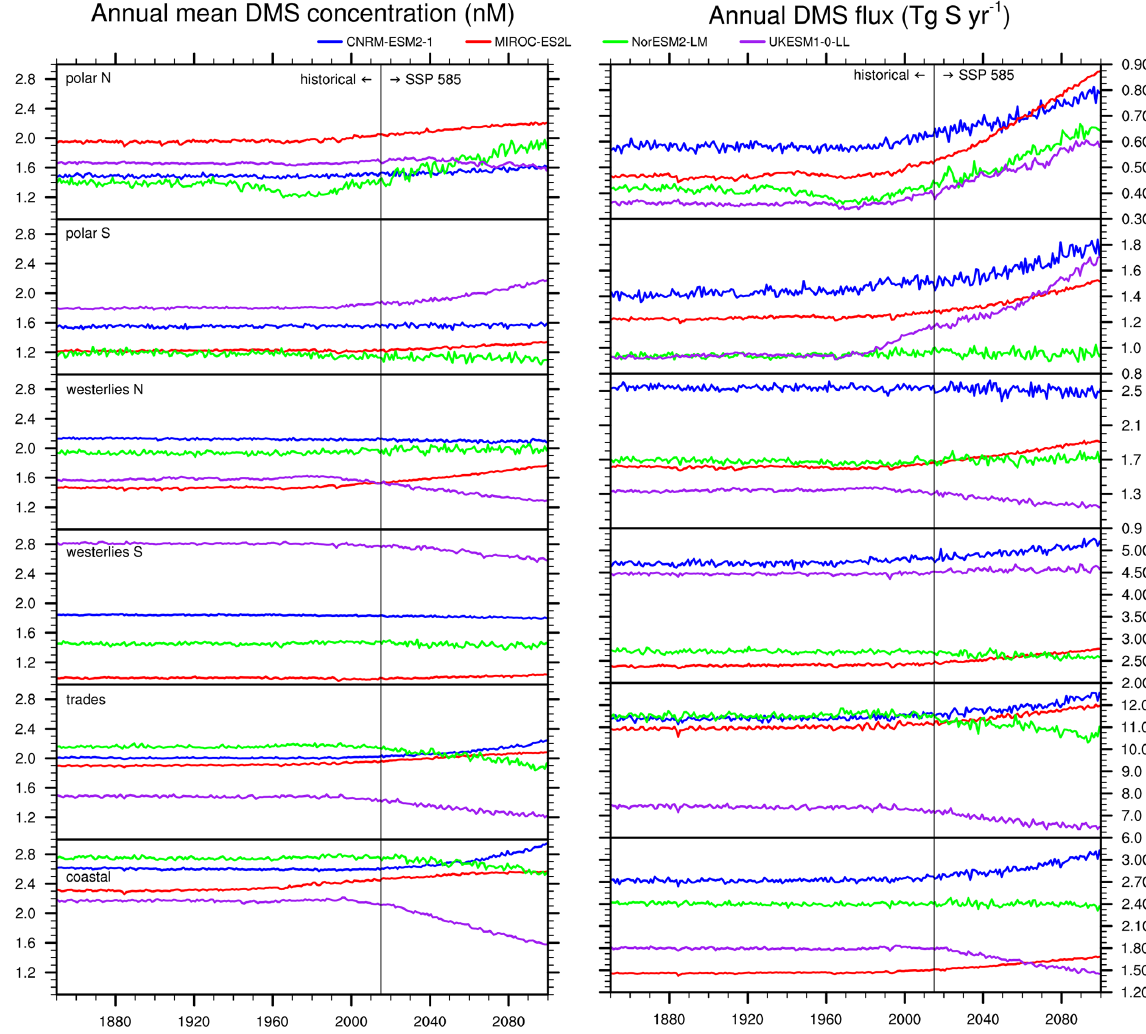
Figure 10. Time series of mean annual area-weighted surface ocean DMS concentration (nM, left panels) and annual regional DMS fluxes (TgSyr − 1 , right panels) over 1850–2100 (CMIP6 historical and ssp585 simulations, model ensemble means). Six different Longhurst (2007) biomes are distinguished, i.e. from top to bottom: polar N, polar S, westerlies N, westerlies S, trades, and coastal (see also Fig. 5 for a mapping of these regions). Please note the common y axis for all DMS concentration